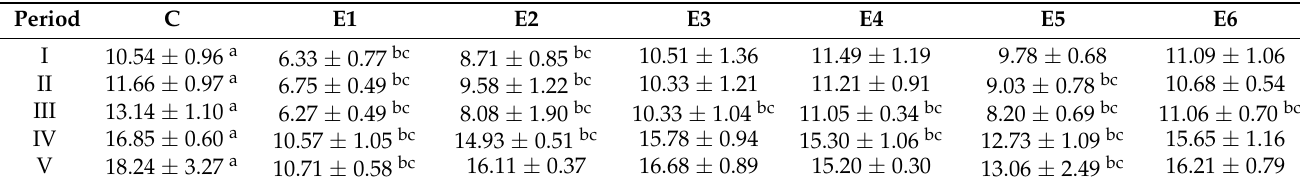
Table 1. Ammonia (NH 3 ) concentrations in the experimental groups during the study (mg/dL).